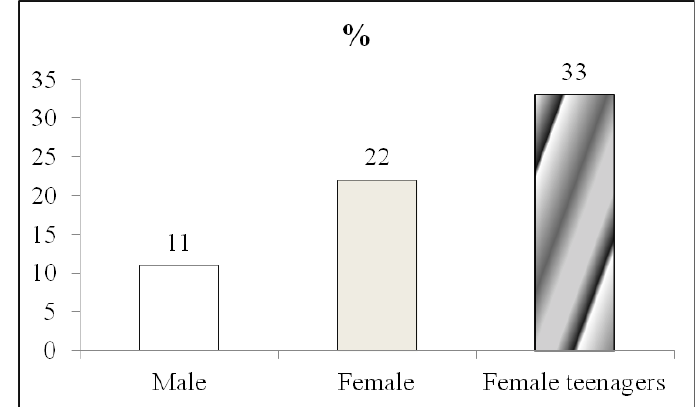
Figure 2. T he percentage of injuries related to years of experience